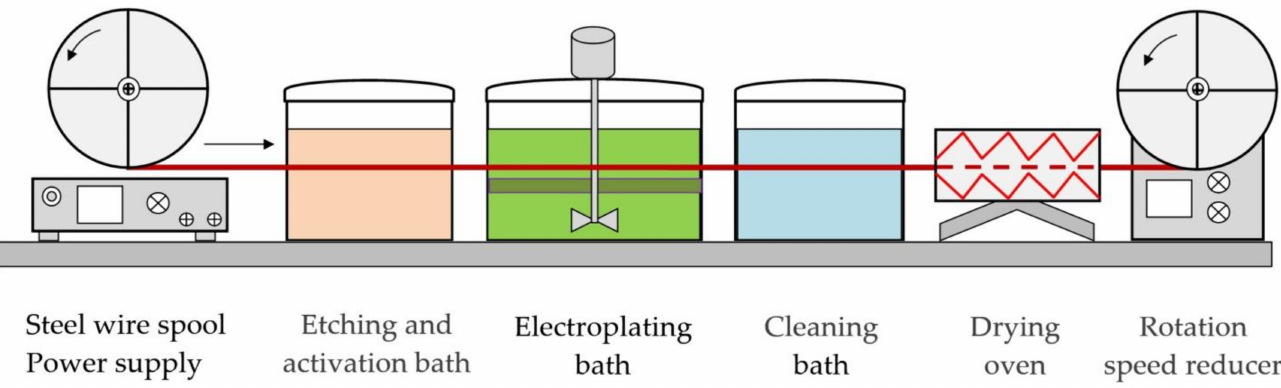
wire is wound in a